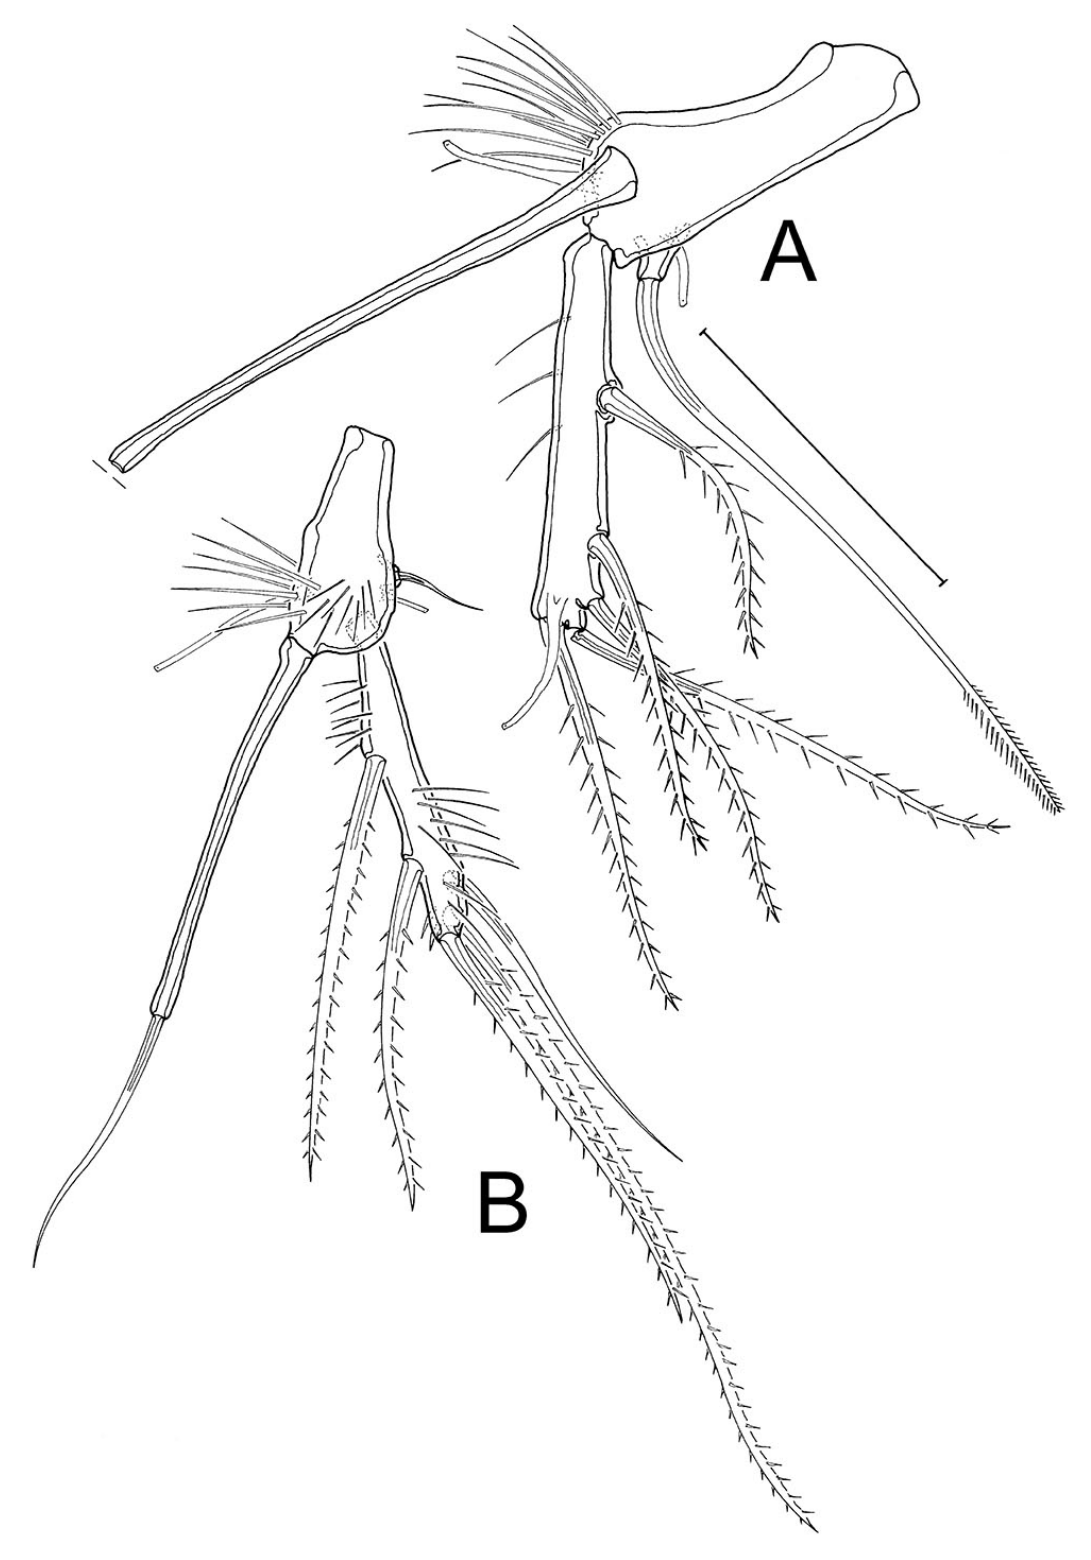
Fig. 13. Paratouphapleura aaroni gen. et sp. nov. A . Female paratype 3 (SMF 37273), P5. B . Male paratype 4 (SMF 37274), P5. Scale bar: 50